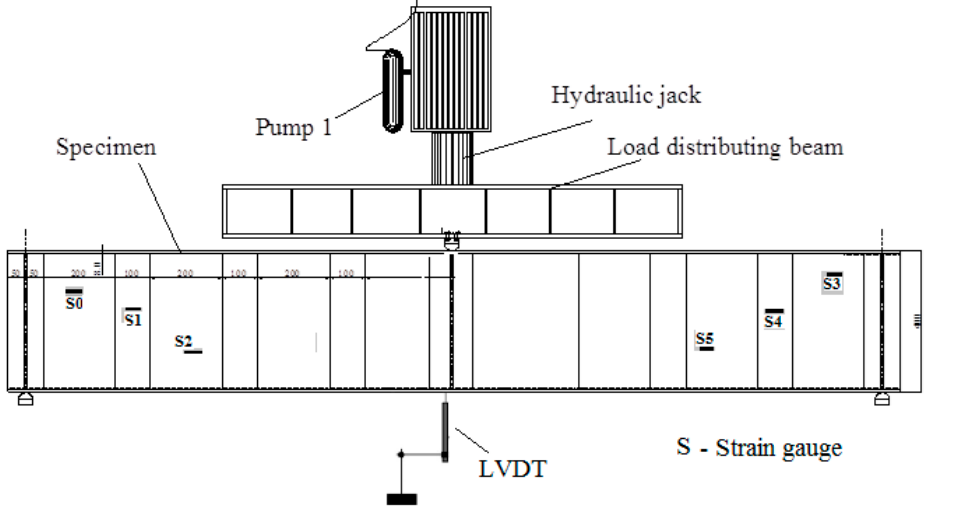
Figure 4. Test scheme.